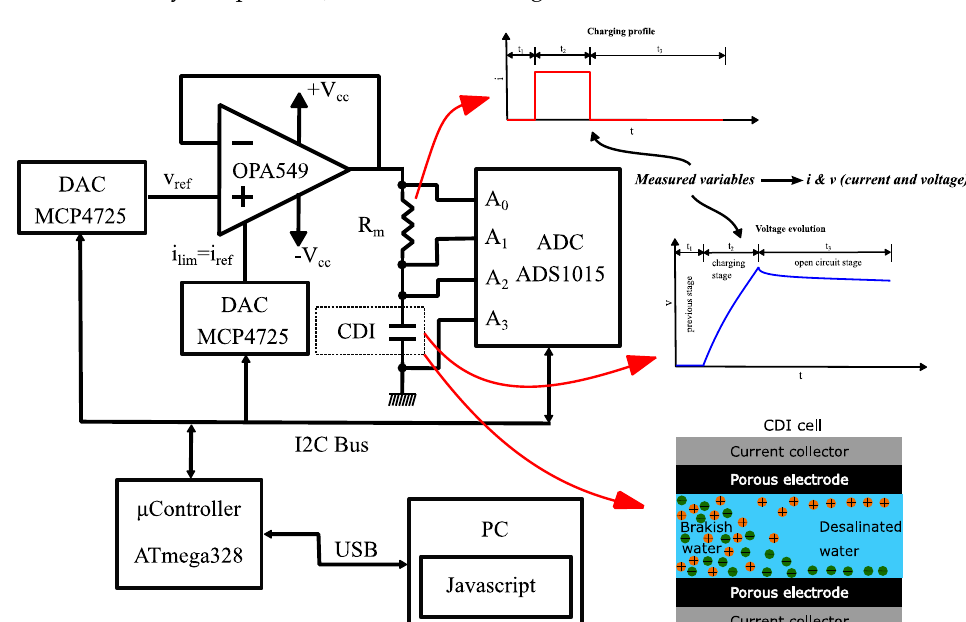
Figure 2. Scheme of the characterization system prototype for capacitive deionization (CSP-CDI).